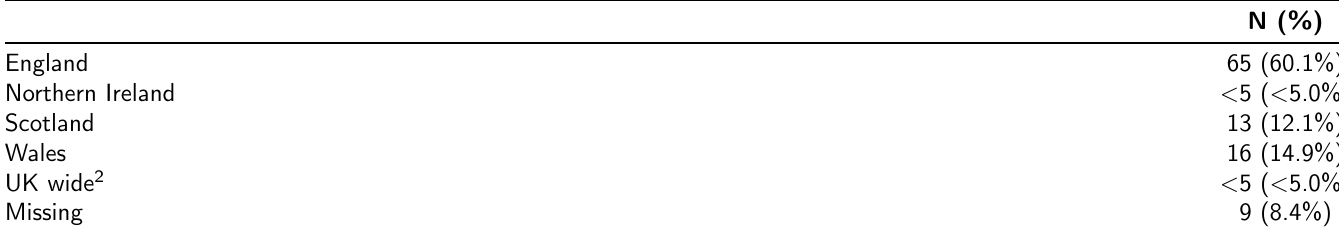
Table 1: Country of employer 1